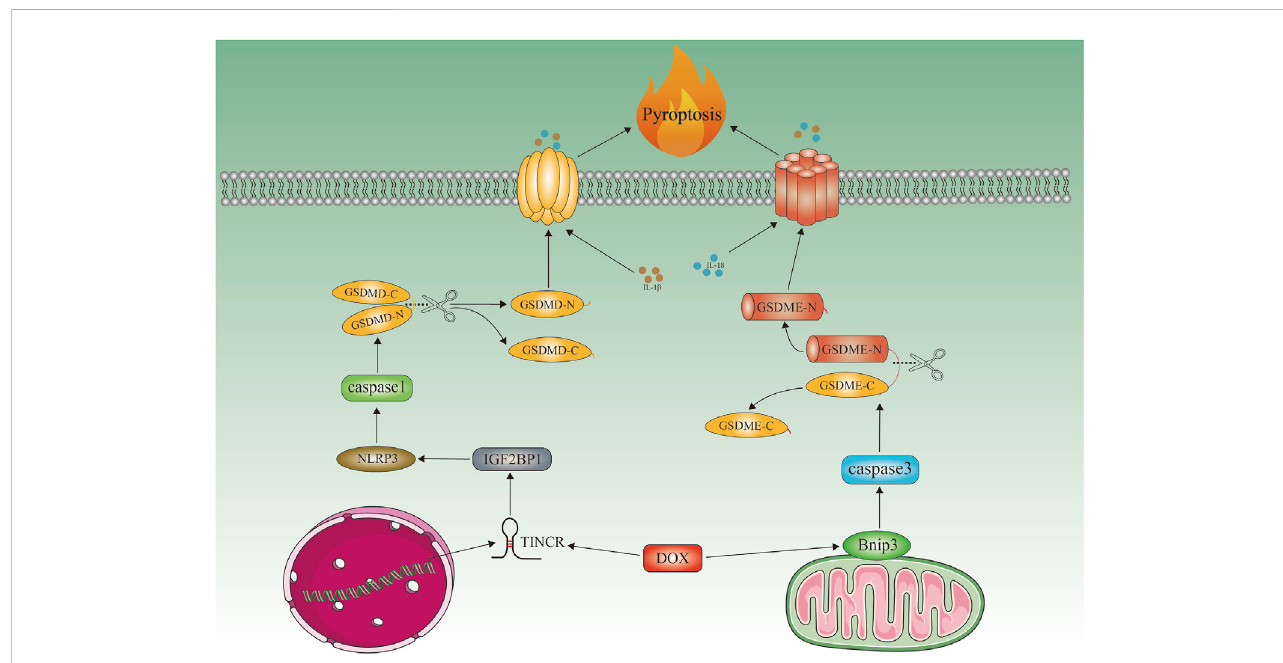
FIGURE 3 Doxorubicin-induced cardiomyocyte pyroptosis. Schematic representation of doxorubicin-induced cardiomyocyte pyroptosis. Doxorubicin recruits IGF2BP and increases NLRP3 expression by upregulating TINCR, which in turn activates caspase1, cleaves GMDSD-N, and releases IL-1 β , IL-18. Doxorubicin activates Bnip3 inmitochondria,which activates caspase3 and causes GSDME-dependent pyroptosis.Bnip3,BCL2-interacting proteinthree; TINCR,terminal differentiation-inducedNcRNA;NLRP3,NOD-,LRR-,andpyrindomain-containingproteinthree;GSDME,gasderminE;GSDMD,gasderminD;IGF2BP1, insulin-like growth factor 2 mRNA-binding protein